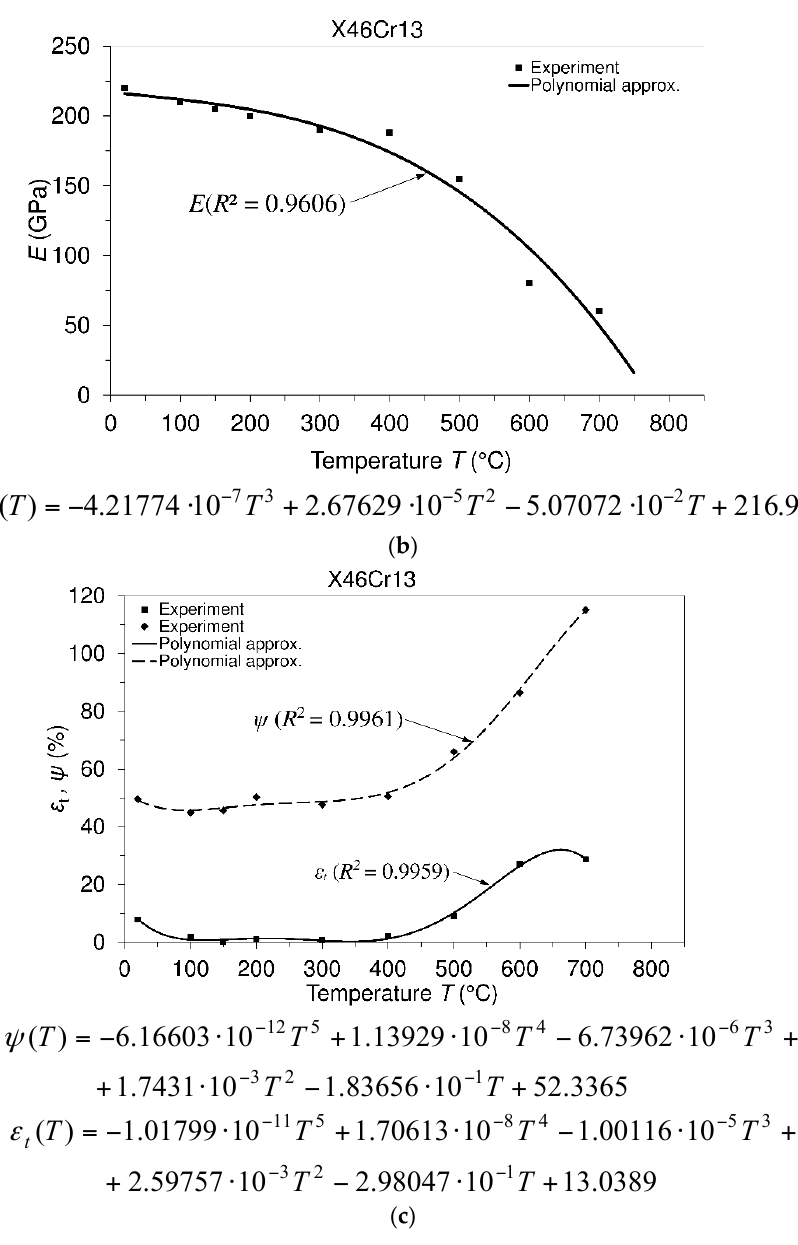
Figure 5 . Material properties versus temperature: X46Cr13 steel. ( a ) Mechanical properties ( σ m , ultimate tensile strength; σ 0.2 , 0.2 offset yield strength) versus temperature; ( b ) modulus of elasticity (E) versus temperature; ( c ) total elongation ( ε t ) and reduction in area ( ψ ) versus temperature.